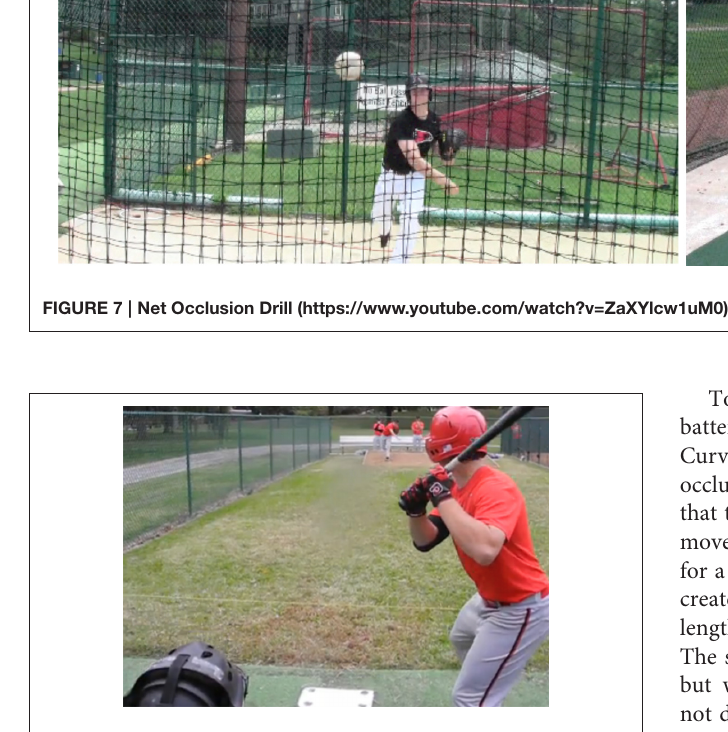
FIGURE 8 | Bullpen Stand-In Pitch Recognition